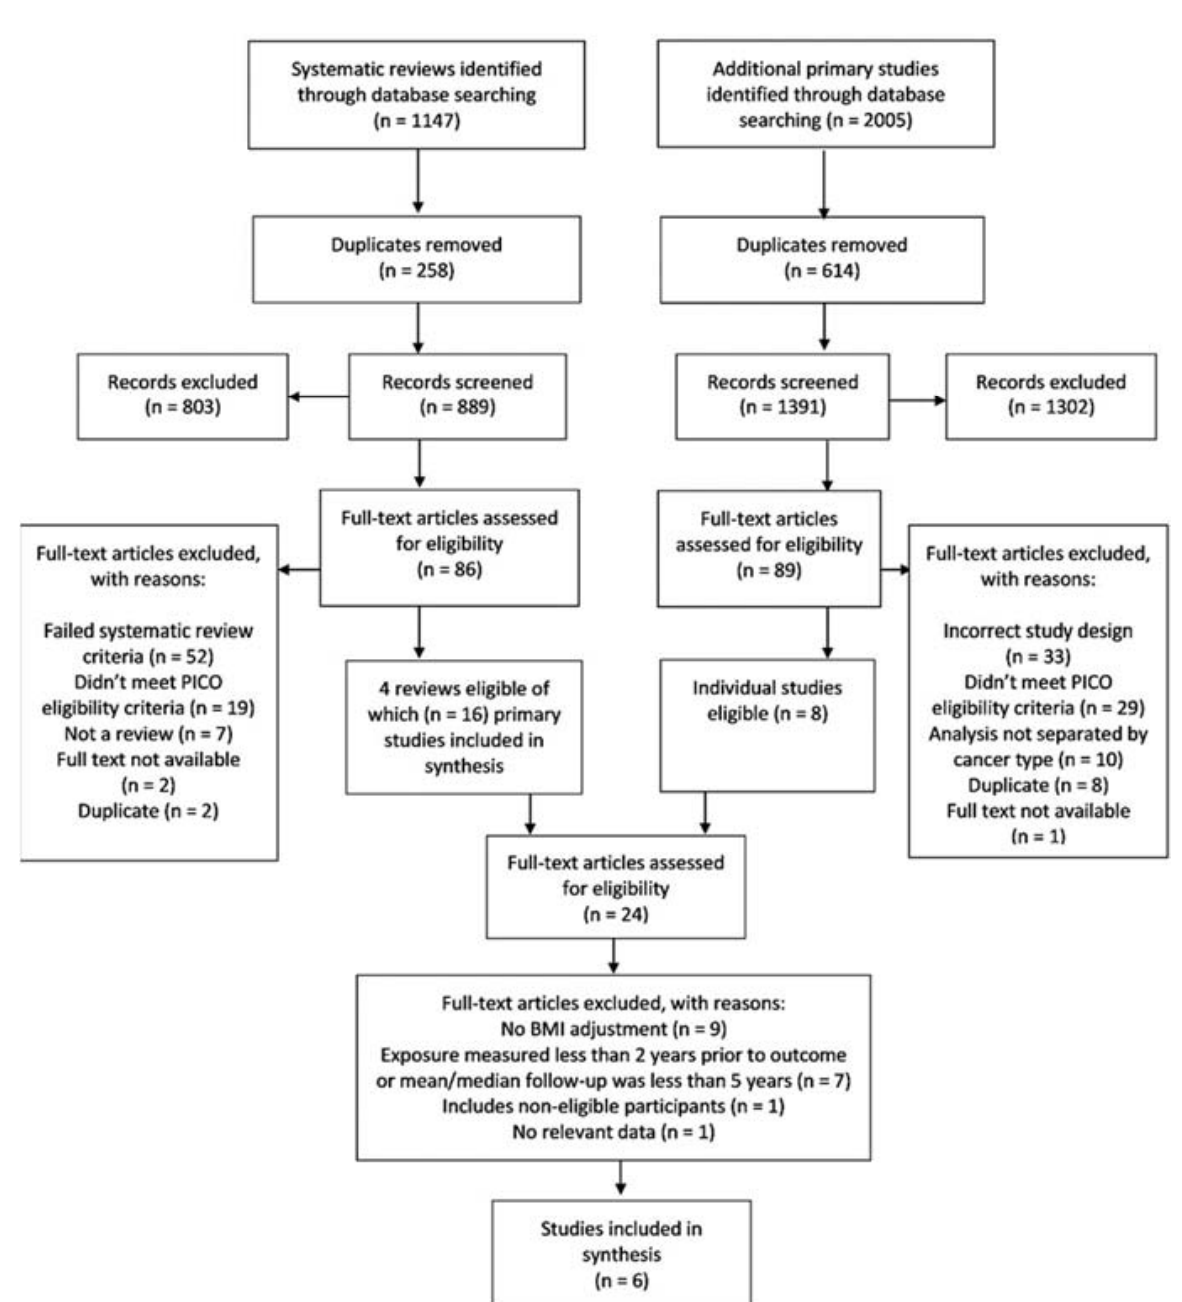
Figure 2. Flow diagram of insulin–prostate cancer association studies identified and included.